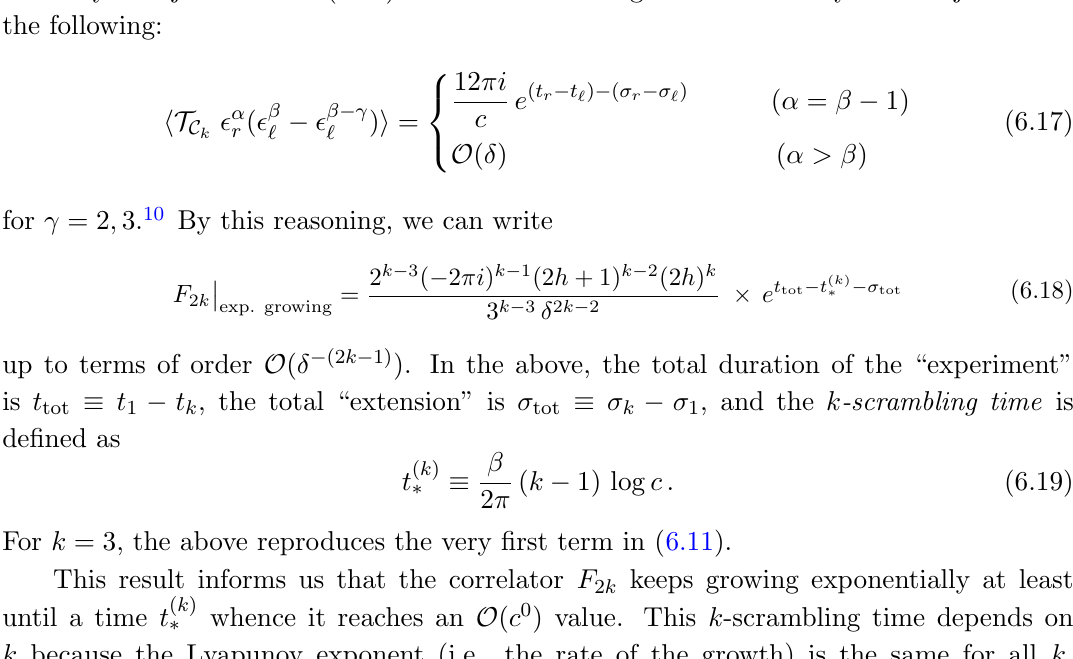
. The red wiggly lines ( h; (cid:22) h )